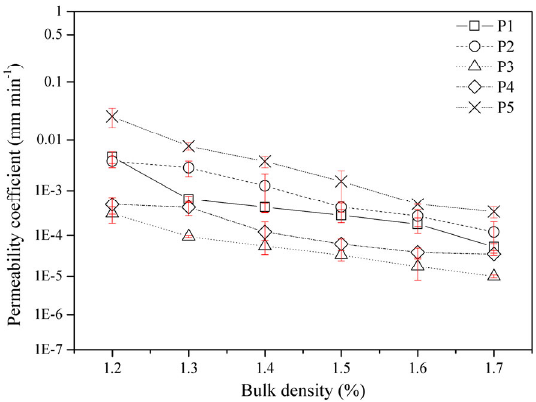
Figure 8. Permeability characteristic for different sample points (P1, P2, P3, P4, and P5) at different